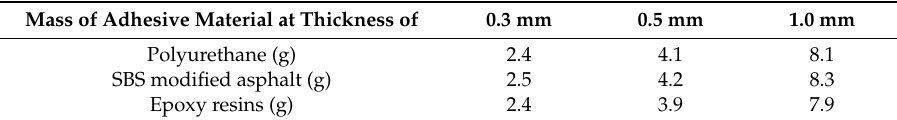
Figure 6. Shear strengths of PPM-10 + AC-20 composite specimen with different adhesive materials and thicknesses at 25 ◦ C. Table 4. The mass of adhesive material for different